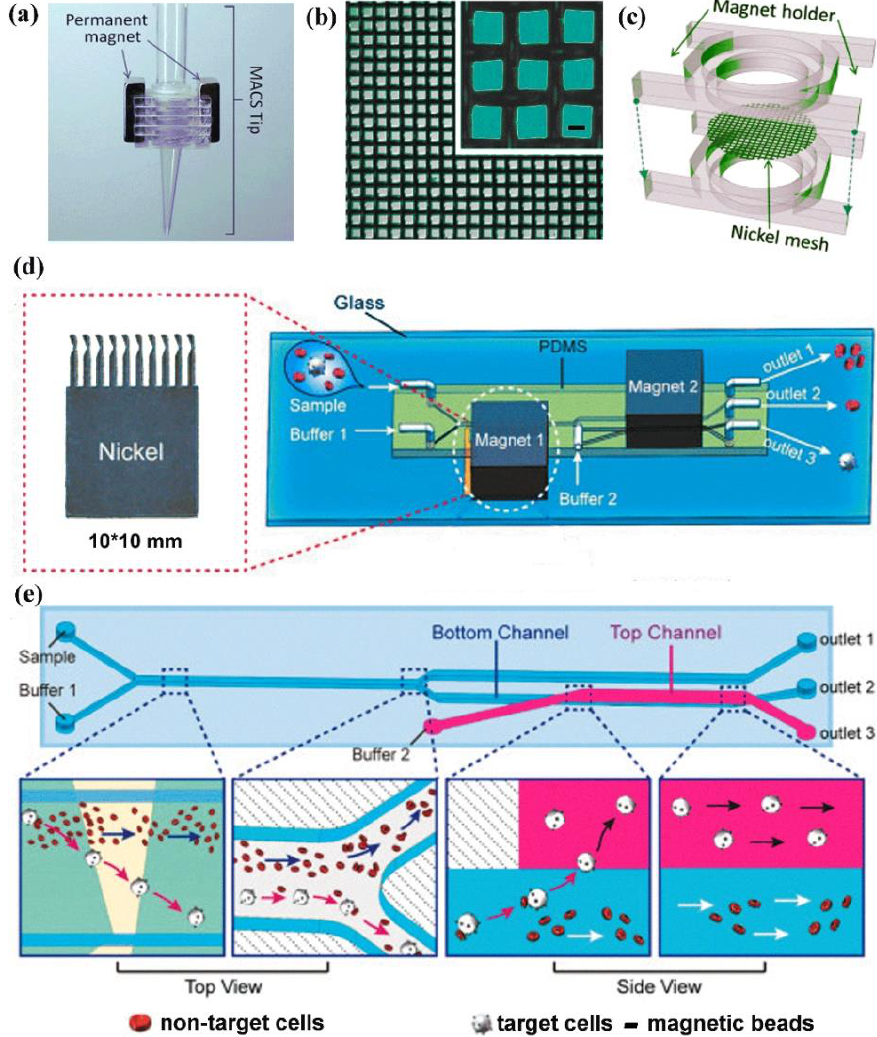
Figure 7. ( a – c ) The structure of the MACS tip [168]; ( d ) the device and ( e ) the separation principle of the magnetic separator which was proposed by Lin et al. [169].